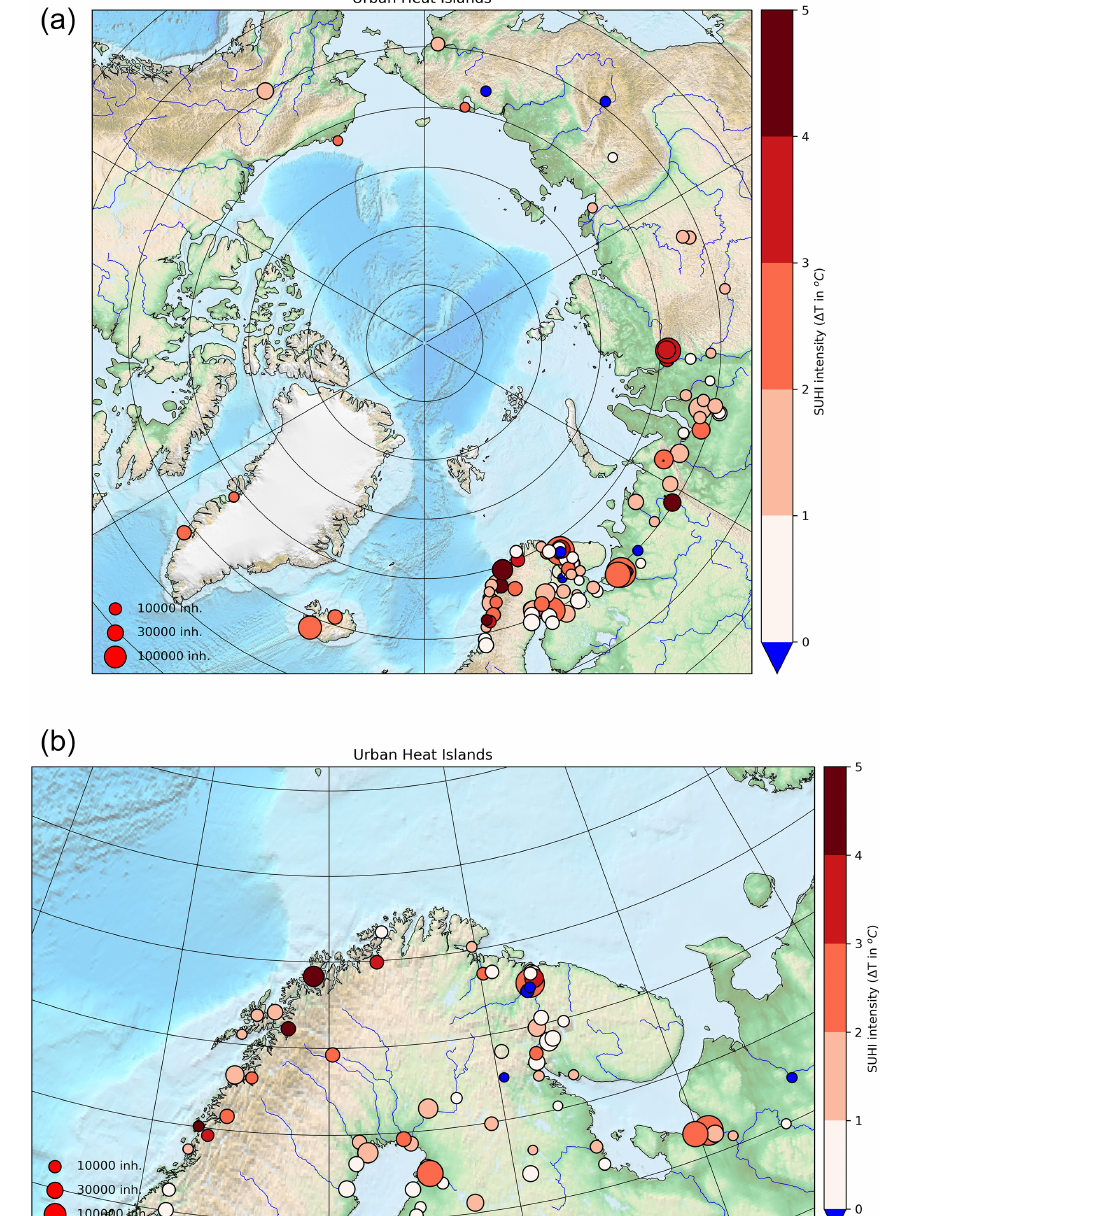
Figure 1. Annual mean magnitude of the surface urban heat islands (the surface UHI intensity) in (a) 118 circum-Arctic cities with more than 3000 inhabitants, and (b) 57 Fennoscandian cities. Data: MODIS LST for